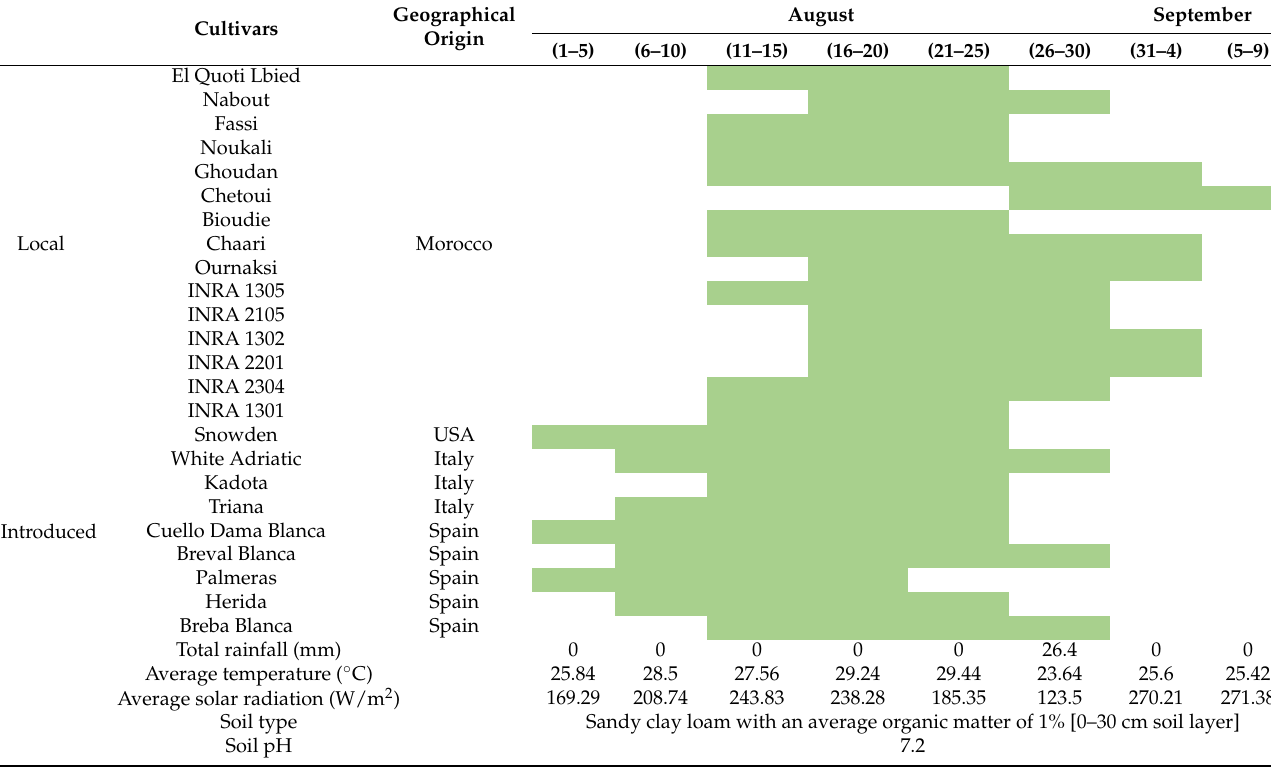
Table 6. Cultivars geographical origins, harvest time and monthly meteorological data from August to early September 2018 in Northern Morocco, Meknes (Ain-Taoujdate experimental